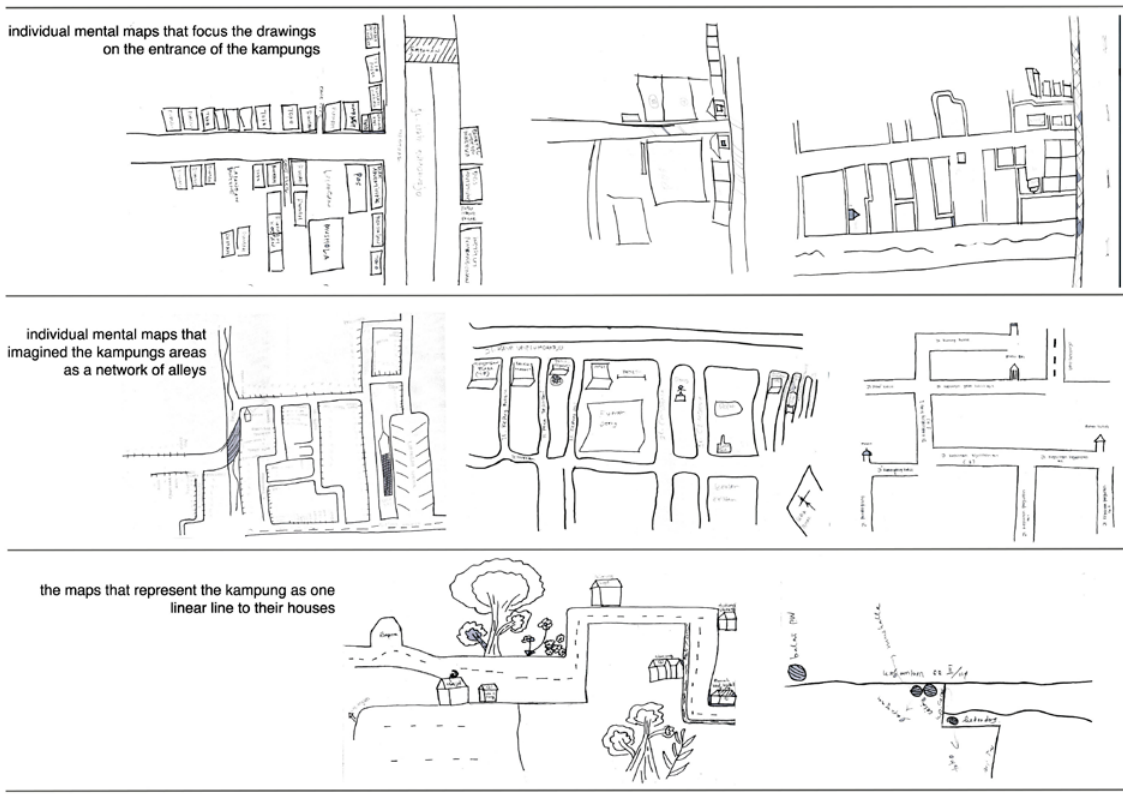
fig. 5. The Kampungs’ maps drawn by the young adults